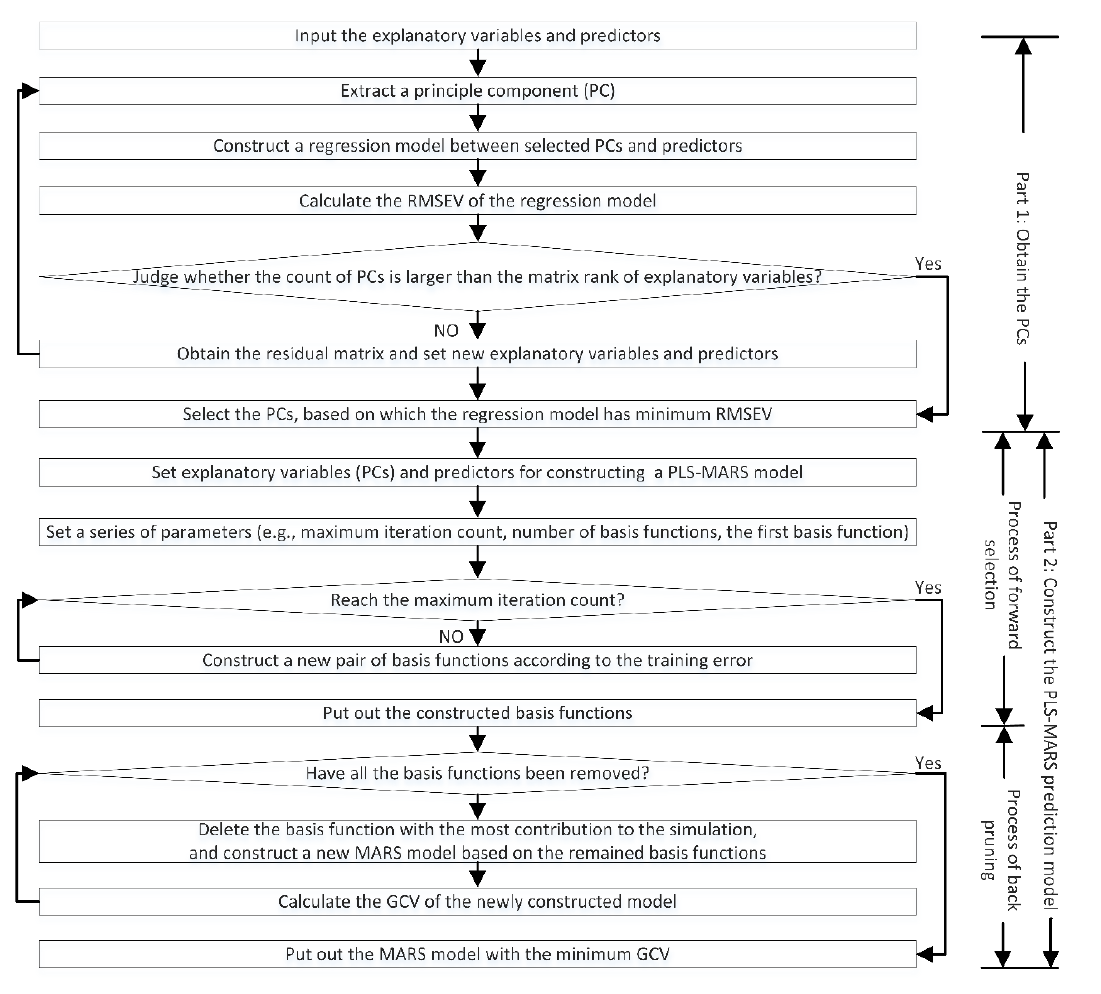
Figure 3. Procedure of constructing the partial least squares–based multivariate adaptive regression spline (PLS–MARS) model.